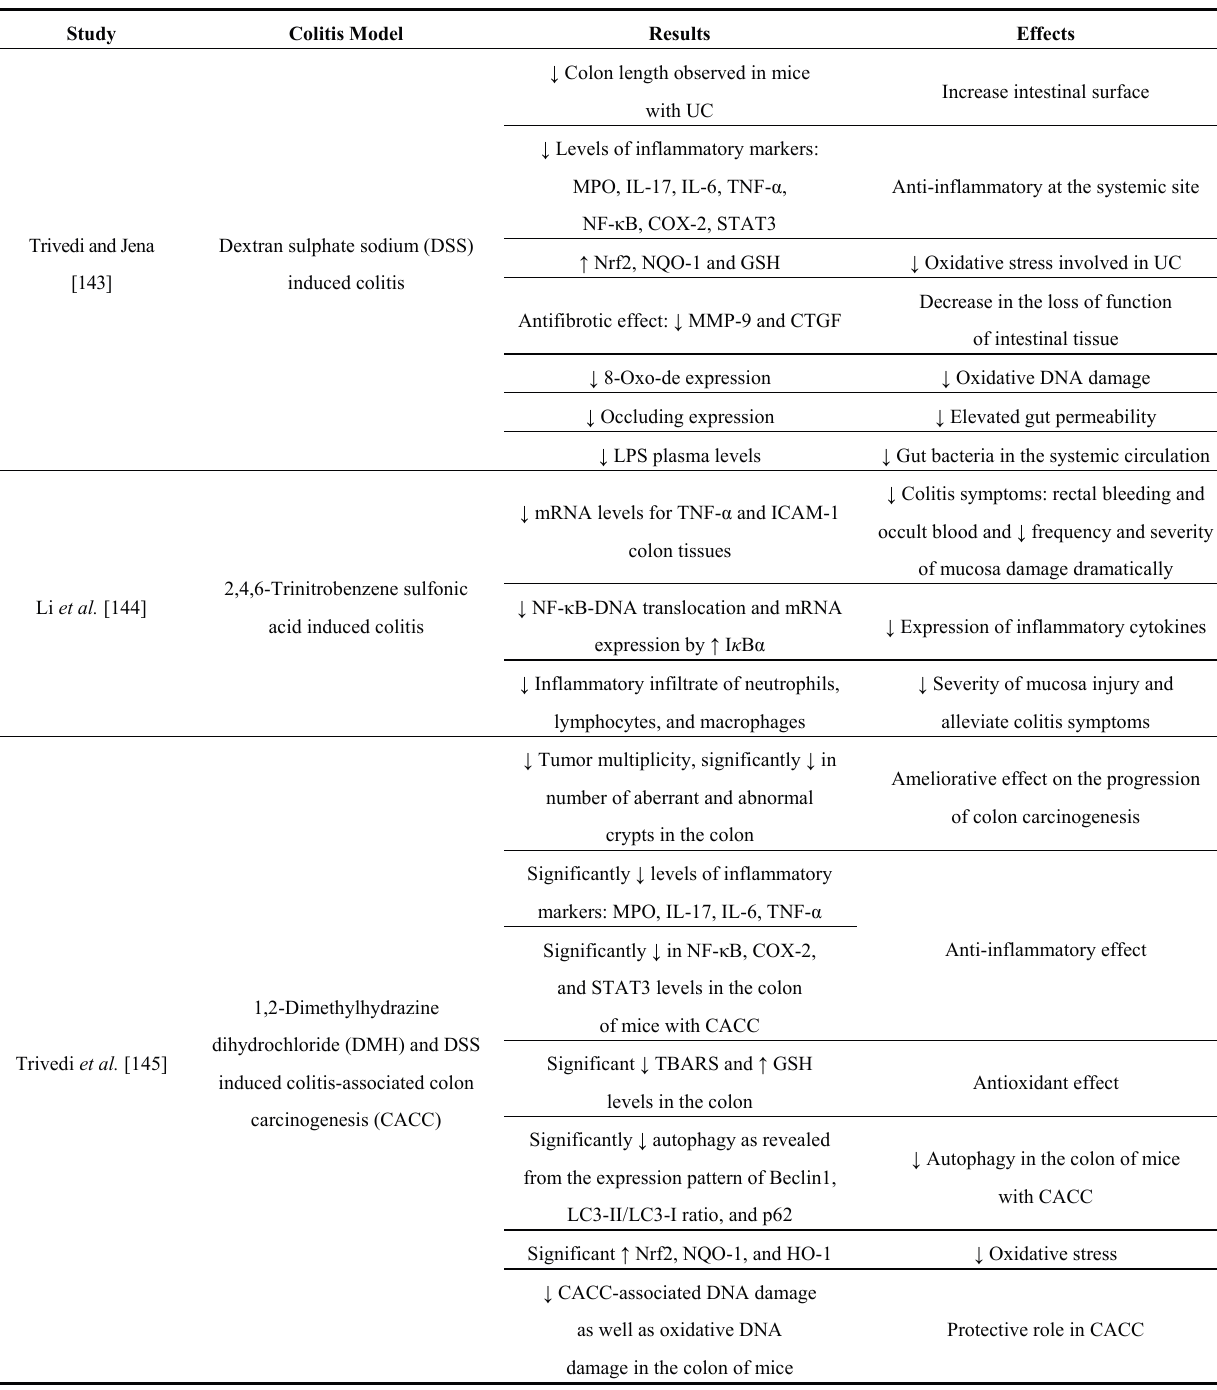
Table 2. Results and effects achieve with the administration of MLT in different animal models of induced UC by different chemical